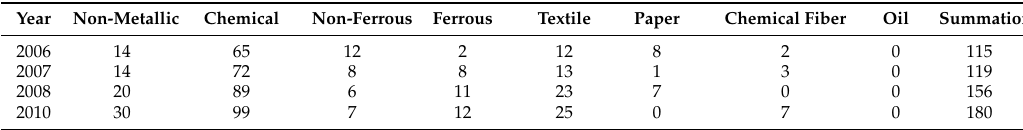
Table 2. The number of transfer enterprises in the eight subsectors from the south to north during